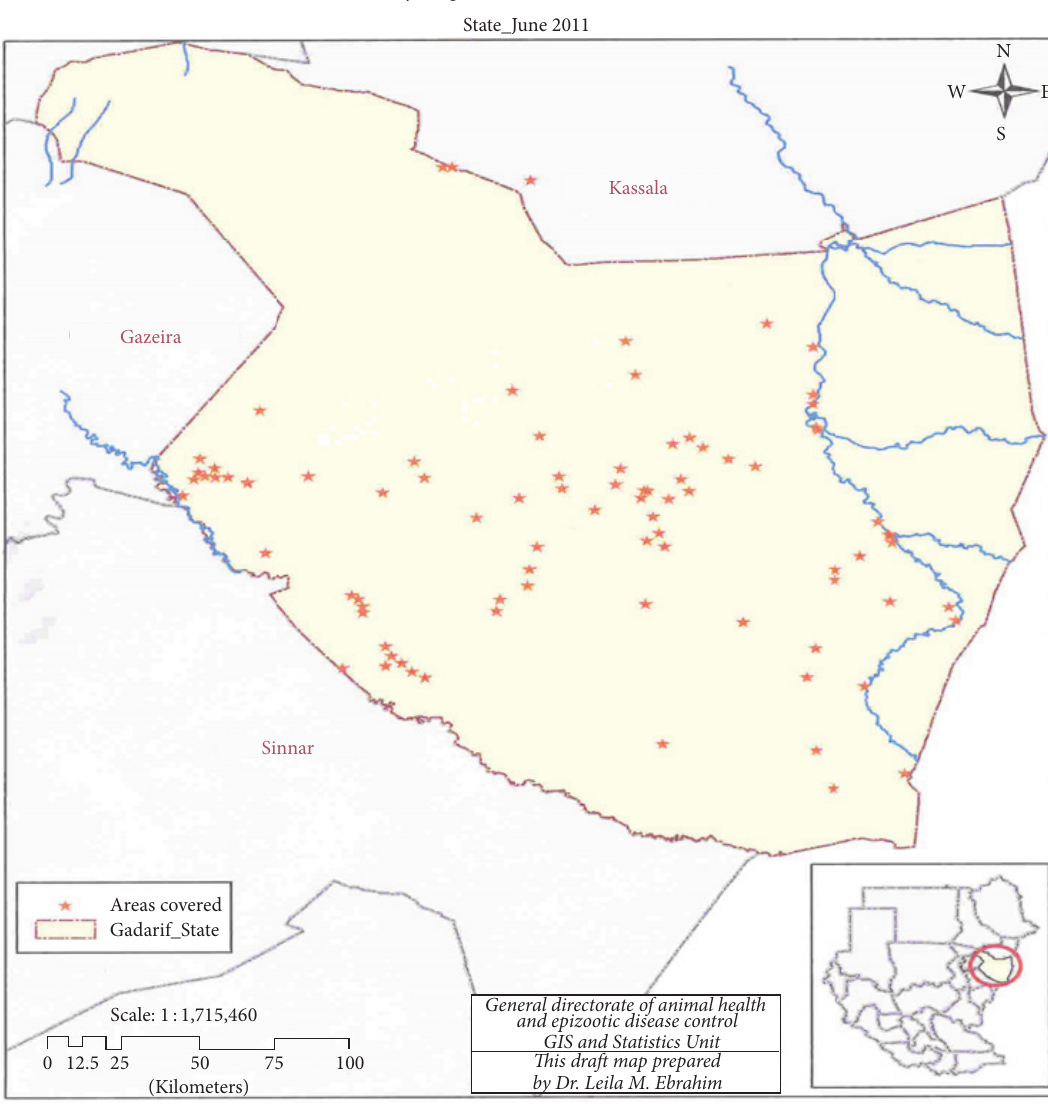
Figure 1: The sampled site in the study area (Gadarif